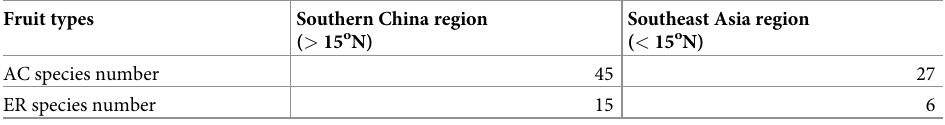
AC and ER stand for acorn and enclosed fruit type respectively. The AC type species, L . elegans is the only species documented to distribute in both regions of southern China and southeast